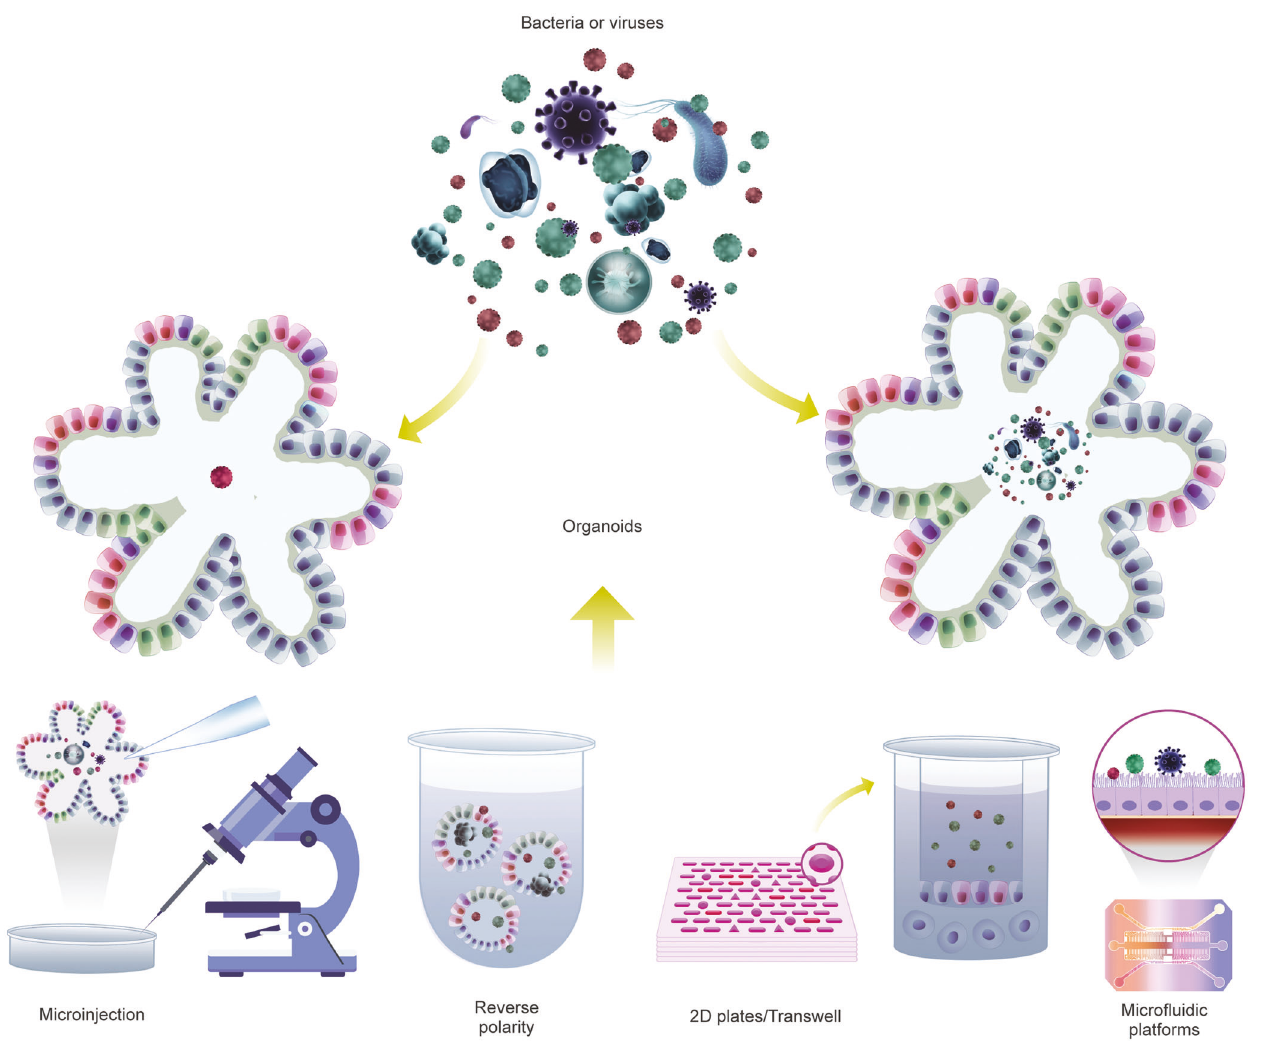
Fig. 3 Using gut organoids to study the impact of microbiota. Methods of infecting organoids with bacteria: (1) Microinjection. (2) Transwell/ Plate-based 2D monolayer cultures of organoids. (3) Reversal of cell polarity of organoids. (4)